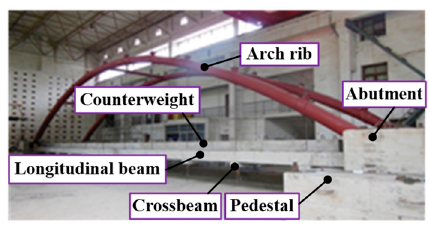
Figure 4. Photo of the test specimen.